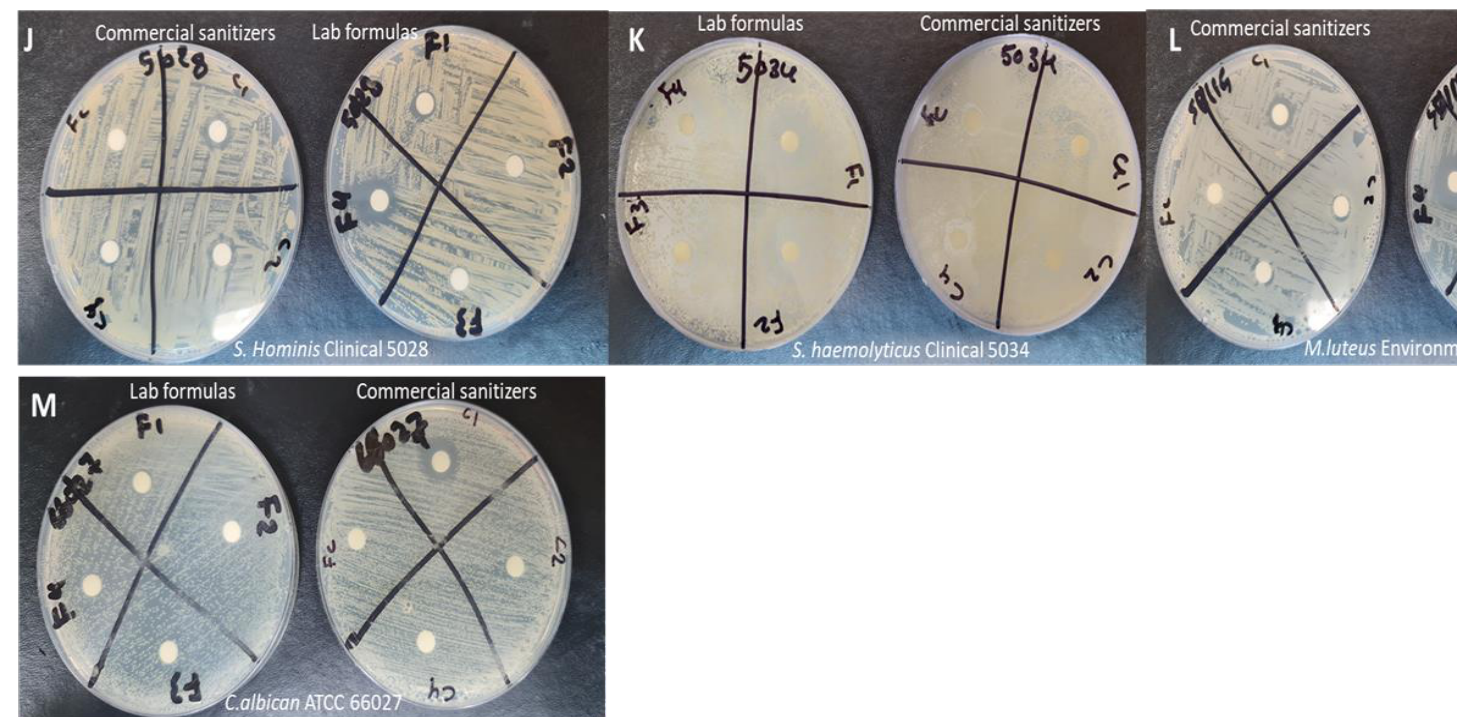
Figure 1. The zone of inhibition diameters of the prepared hand sanitizers compared to three commercially available hand sanitizers (C1, C2, and C3) against (A): A. baumannii - BAA 747; (B): E. coli - ATCC 25922; (C): E. coli - MDR 1060; (D): K. pneumoniae - BAA 1705; (E): P. aeruginosa - BAA 1744; (F): P. aeruginosa - ATCC 27853; (G): S. aureus - ATCC 29213; (H): S. aureus - BAA 977; (I): S. epidermidis - isolate 5029; (J): S. homini - isolate 5028; (K): S. haemolyticus - isolate 5034; (L): M. luteus - isolate SB 115; and (M): C. albicans - ATCC 66027. The clove EO-based hand sanitizers in both concentrations inhibited all bacterial strains and the yeast (13 microorganisms in total). The tea tree hand sanitizer had the highest efficient antibacterial activity (inhibited the 12 bacterial strains), but lacked anti-yeast activity. The lavender hand sanitizer was the least efficient hand sanitizer gel, with the least antibacterial inhibition spectrum (effective against 10 bacterial strains) and no anti-yeast activity. The commercially available hand sanitizers were able to inhibit all bacterial strains, but with variable efficacies, while the oil-free control formula showed no antibacterial effect against all tested bacteria, except S. epidermidis . The ethanol-based control (C1) showed anti-yeast activity against C. albicans .